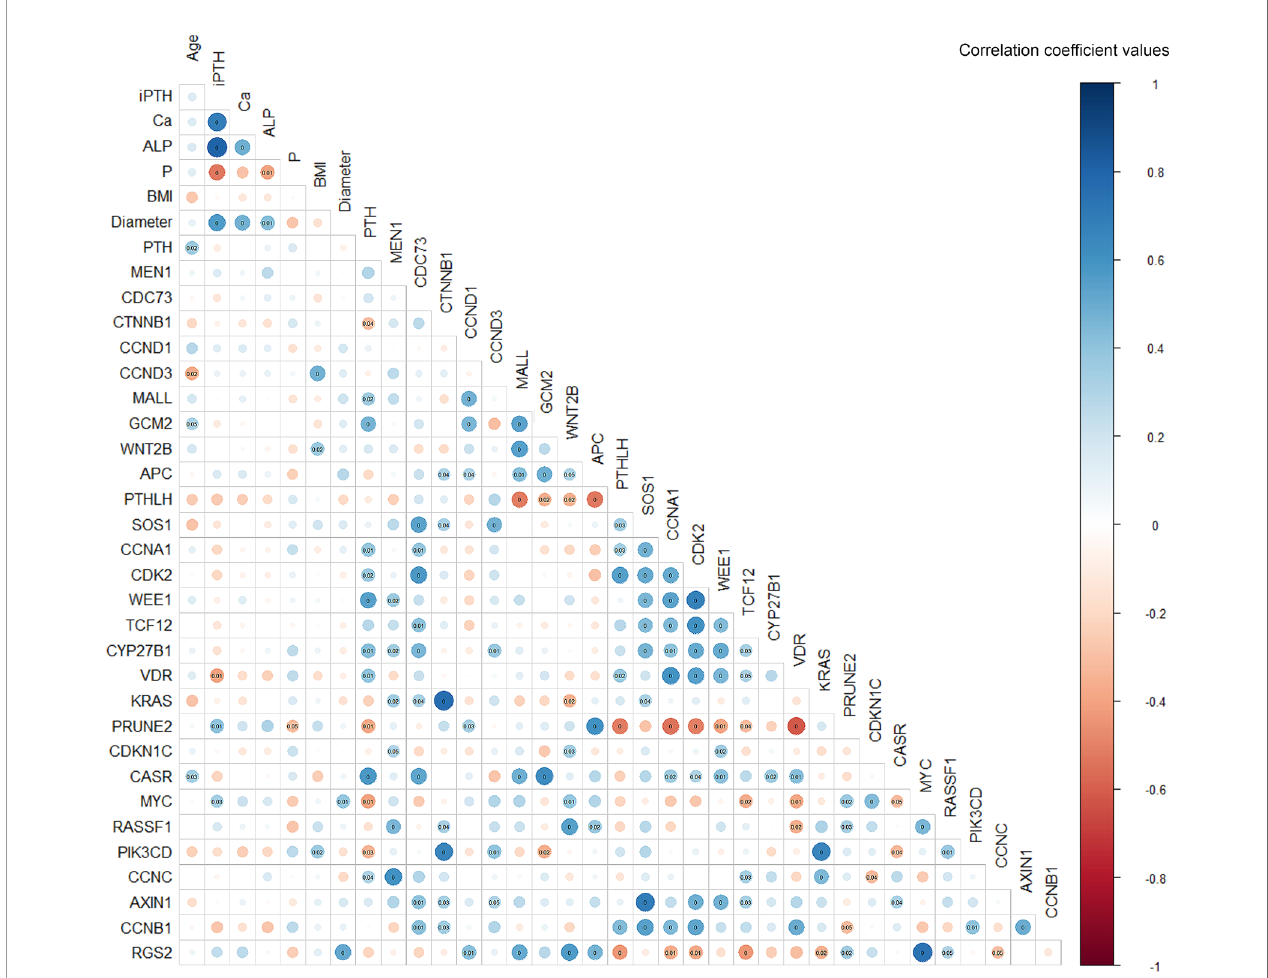
FIGURE 4 | Spearman ’ s correlation matrix between gene expression and clinicopathological features in parathyroid adenoma. The correlation coef fi cient values are visualized by the size and color intensity of the circles. Positive and negative correlations are represented by blue and red, respectively. P-values below 0.05 are marked in the matrix, with P-values below 0.01 marked as zero. iPTH, serum intact parathyroid hormone level; Ca, serum calcium level; ALP, serum alkaline phosphatase; P, serum phosphorus level; BMI, body mass index; Diameter, maximum diameter of the parathyroid